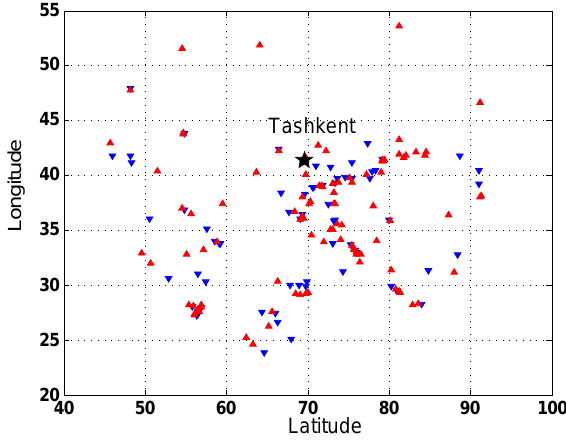
Fig. 6. Position of the earthquake epicentres relative to the ver- tical sounding station “Tashkent”. Red points show earthquakes for which foEnorm on the day ( − 1) is larger than the mean value, blue points designate earthquakes with a foEnorm-value on day ( − 1) smaller than the mean value .